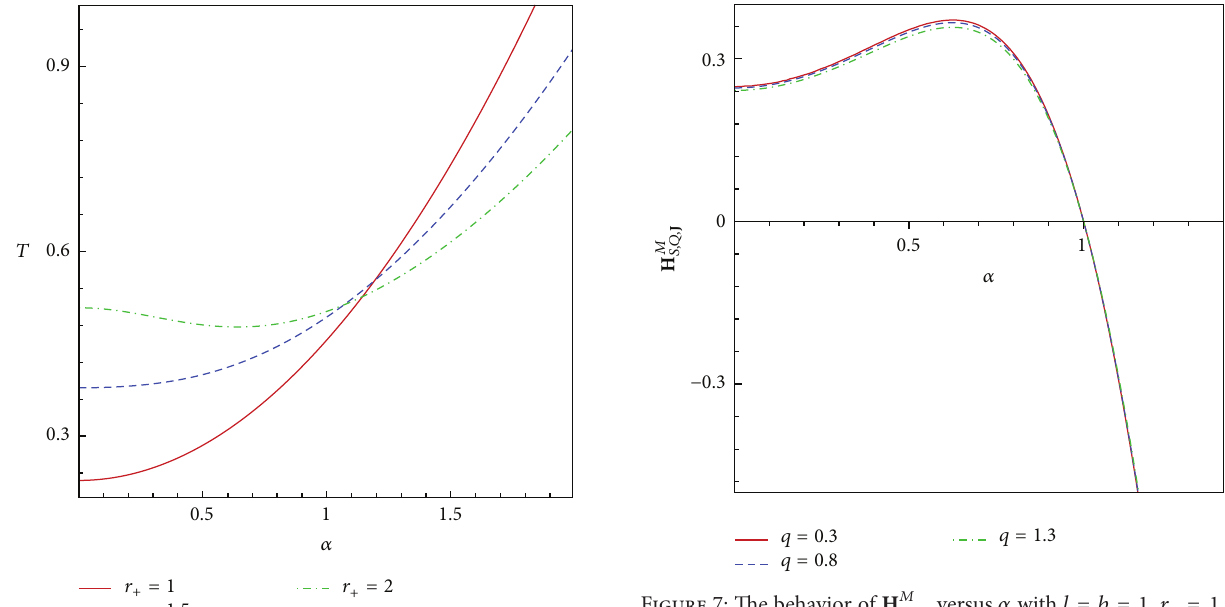
Figure 7: The behavior of H 𝑀 𝑆,𝑄, J versus 𝛼 with 𝑙 = 𝑏 = 1 , 𝑟 + = 1.5 , Ξ = 1.25 , 𝑛 = 5 , and 𝛽 = 2 .